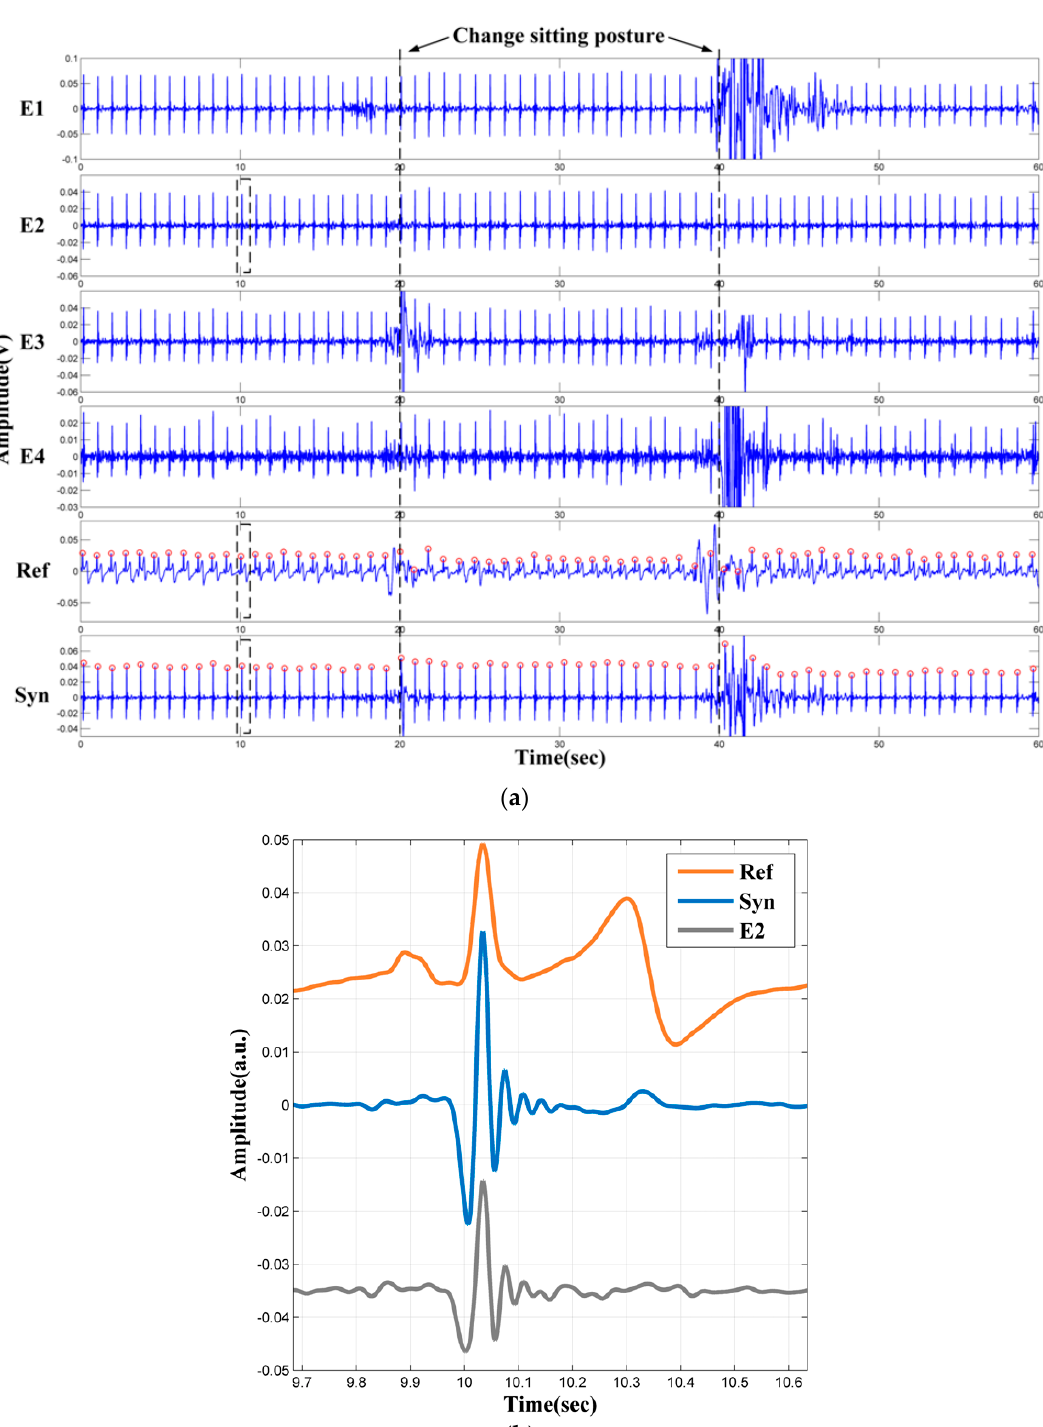
Figure 12. One-minute measurement results: ( a ) The measured ECG signals and the synthetic results; ( b ) Details of the ECG waveforms (near 10 s).